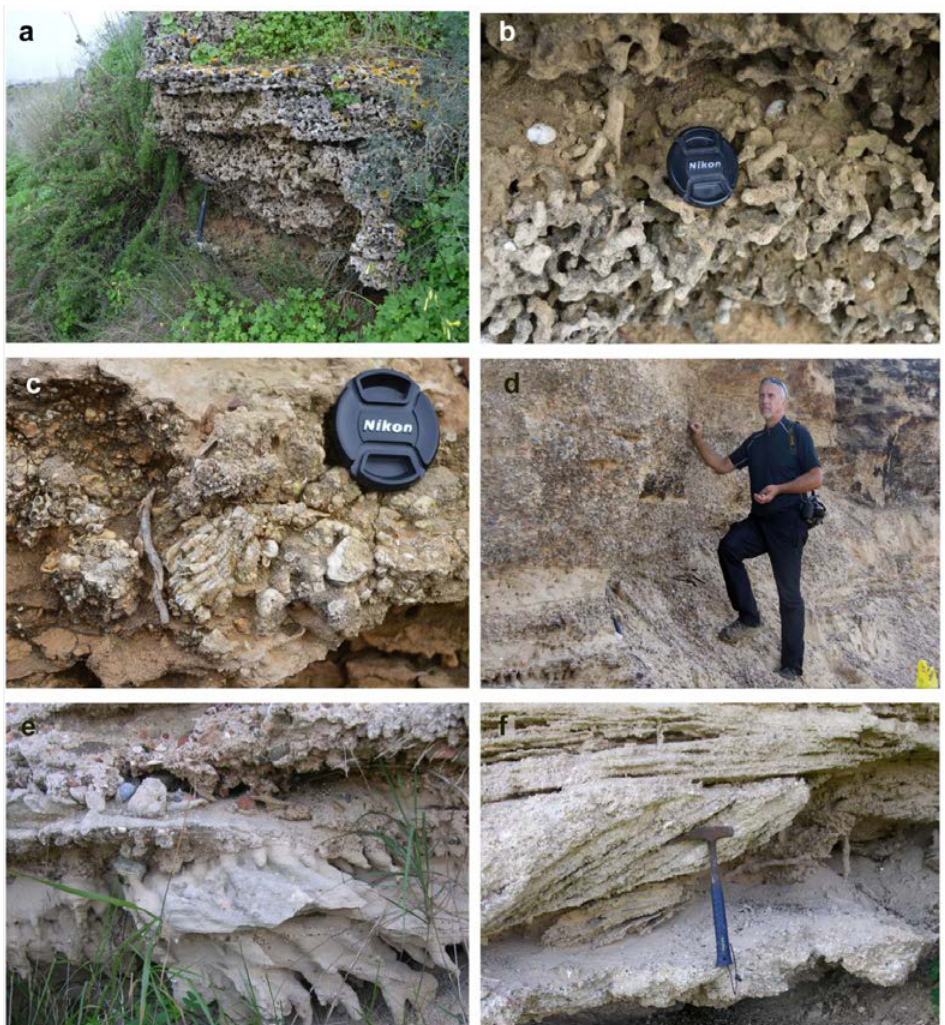
Figure 5. (a) A view of the section of Sa Illetta marine interglacial fossiliferous sediments [8]; tidal plain sandy littoral deposit irregularly cemented with burrows bioturbation structures and plane-parallel lamination (Sections 1 and 2); ( b ) Section 2 bottom 2a, particular of the icnofacias due to the activity of Polychaetes; ( c ) Section 2 top 2d, bioclastic sandstone well cemented containing Lithtaminium and bioconstructions in Cladocora coespitosa − 149 ± 10 kyrs BP [23] ; ( d ) A view of the section of the last interglacial interdidal fossiliferous sediments of Is Arenas (Section 3, 2a) bottom level with burrows bioturbation structures containing Persististrombus latus [23]; ( e ) At the top conglomeratic heterometric and polygenic fos- siliferous level (Section 3, 2b), at the bottom weakly cemented sandstones and sands with channeled flow structures in a tidal plane environment (Section 3, 2a); ( f ) sub-horizontal laminated sandstone enclosing a forest level containing Arca Noae Limne, Arca tetragona tetragona Poli, Glycimeris sp . 111 kyrs BP